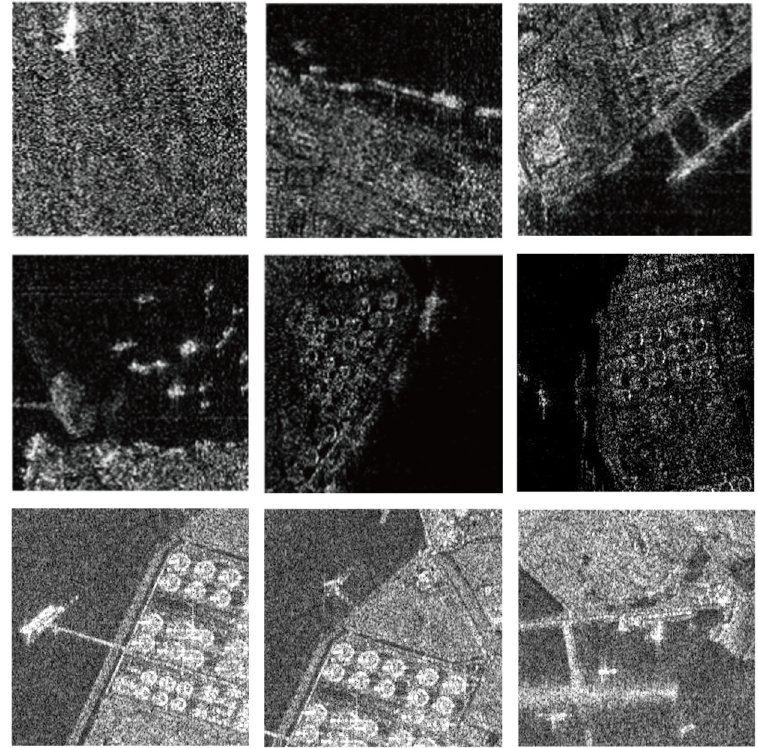
Figure 10. Illustration of the noise challenging of MSAR dataset.